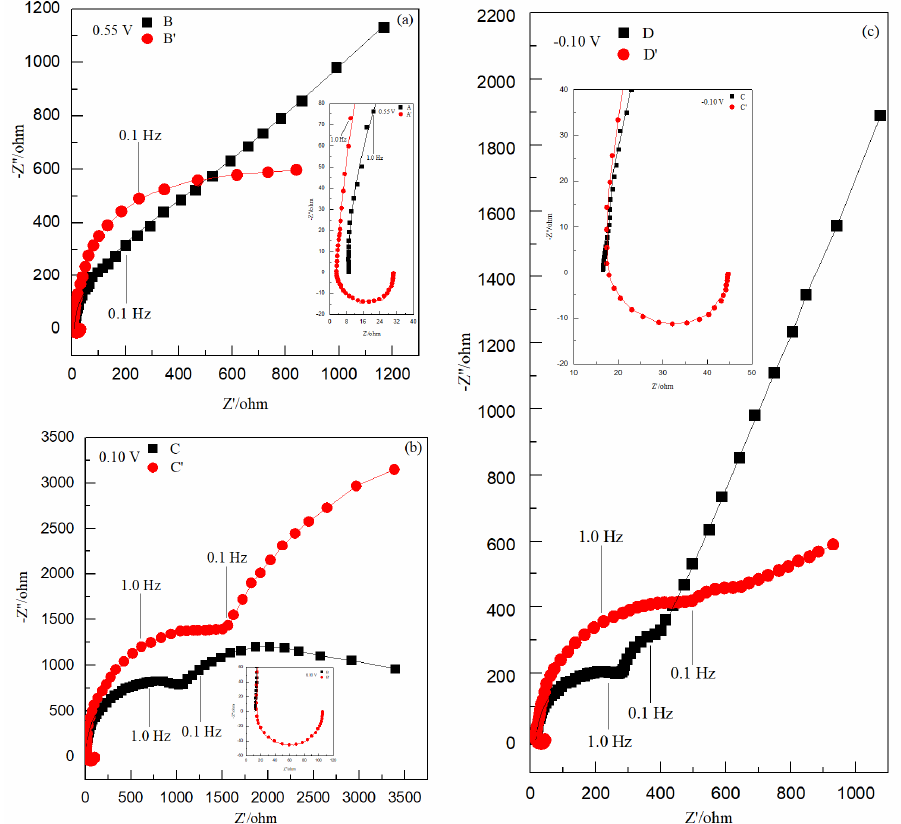
Figure 3. Nyquist plots obtained at different potentials in Se( Ⅳ ) unitary solutions: ( a ) 0.55 V, curve B in solution 3 without PEG; curve B ′ in solution 4 with 4 μ M PEG; ( b ) 0.10 V, curve C in solution 3 without PEG; curve C ′ in solution 4 with 4 μ M PEG; and ( c ) − 0.10 V, curve D in solution 3 without PEG; curve D ′ in solution 4 with 4 μ M PEG. Inset: Partly amplified Nyquist plots of ( a – c ). Curve B ′ , curve C ′ , and curve D ′ in Figure 3 all have one more inductive loop than curve B, curve C, and curve D; these inductive loops suggest that there was an adsorption